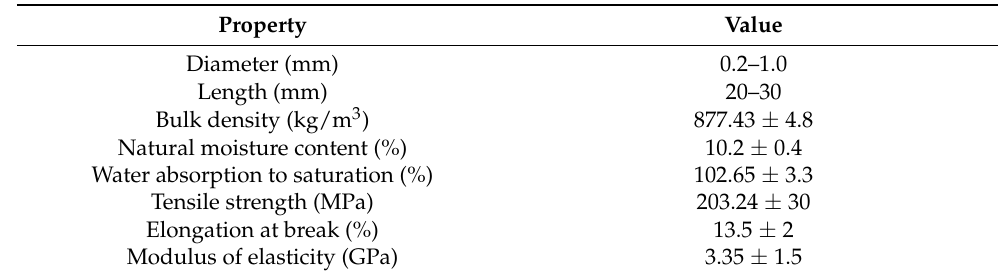
Figure 3. Coarse aggregate gradation. Table 2. Properties of DPF